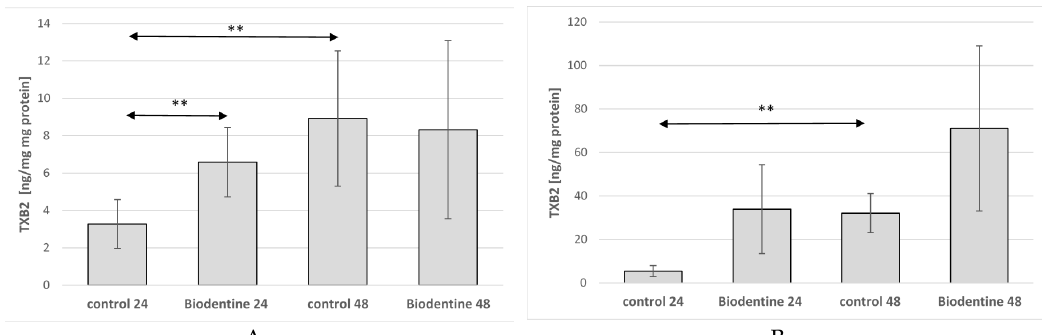
Figure 6. The concentration of thromboxane TXB2 (TXB2) in THP-1 monocytes ( A ) and macrophages ( B ) cultured with Biodentine TM . Cells were cultured for 24 h and 48 h in RPMI medium with 10% FBS with Biodentine TM , after incubation the cells were harvested by scraping and TXB2 concentration was measured by ELISA. Control cells were incubated in RPMI medium with 10% FBS. Experiments were conducted as six separate assays (each assay in three replicates). ** Statistically significant differences in comparison to control 24 ( p ≤ 0.05), (U-Mann-Whitney test).